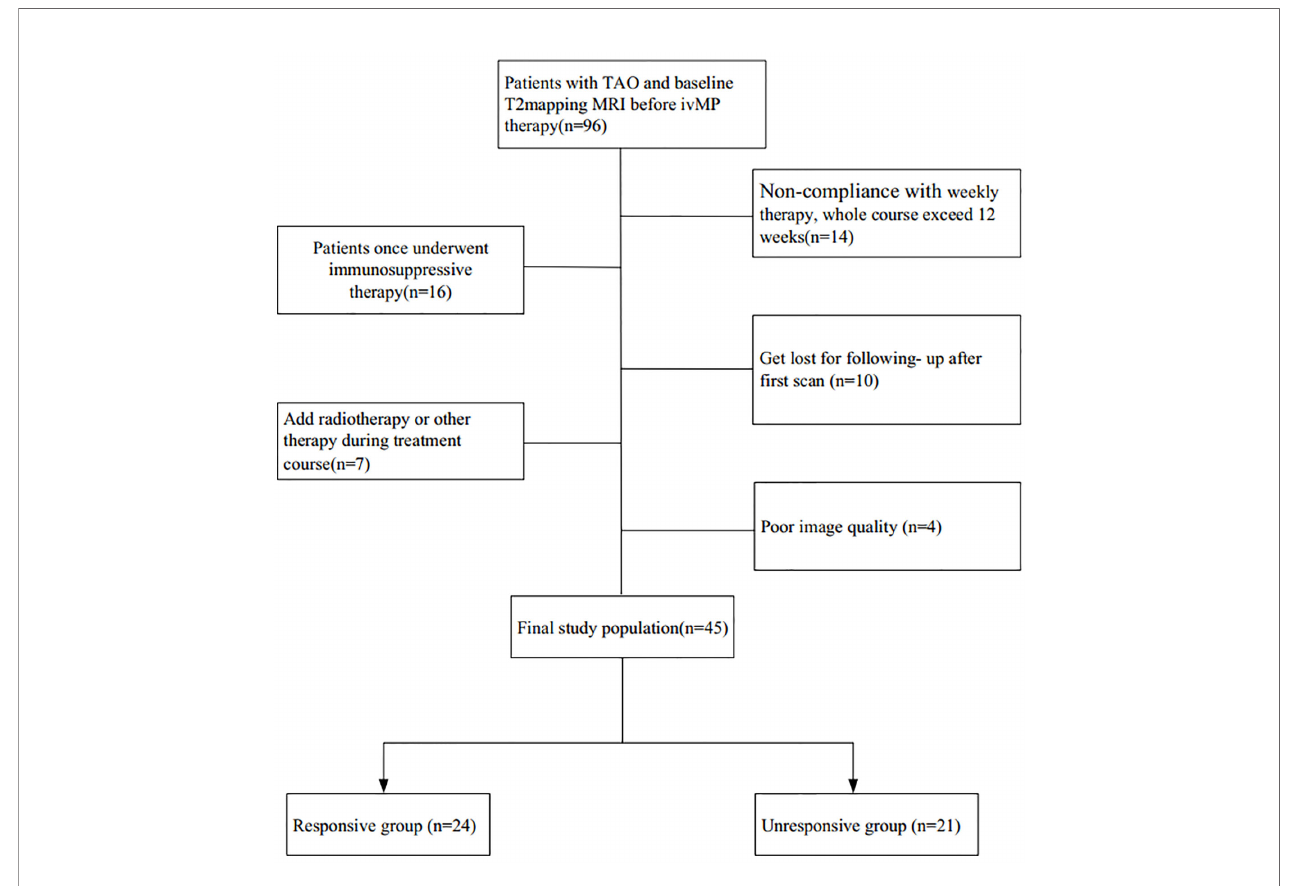
FIGURE 1 | Flowchart of the patient enrollment